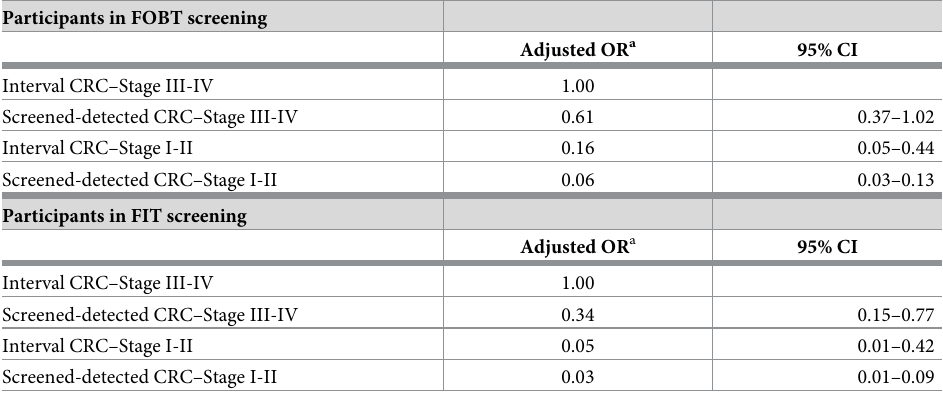
Table 3. Interaction analysis between screen-detected colorectal cancers and interval cancer and TNM